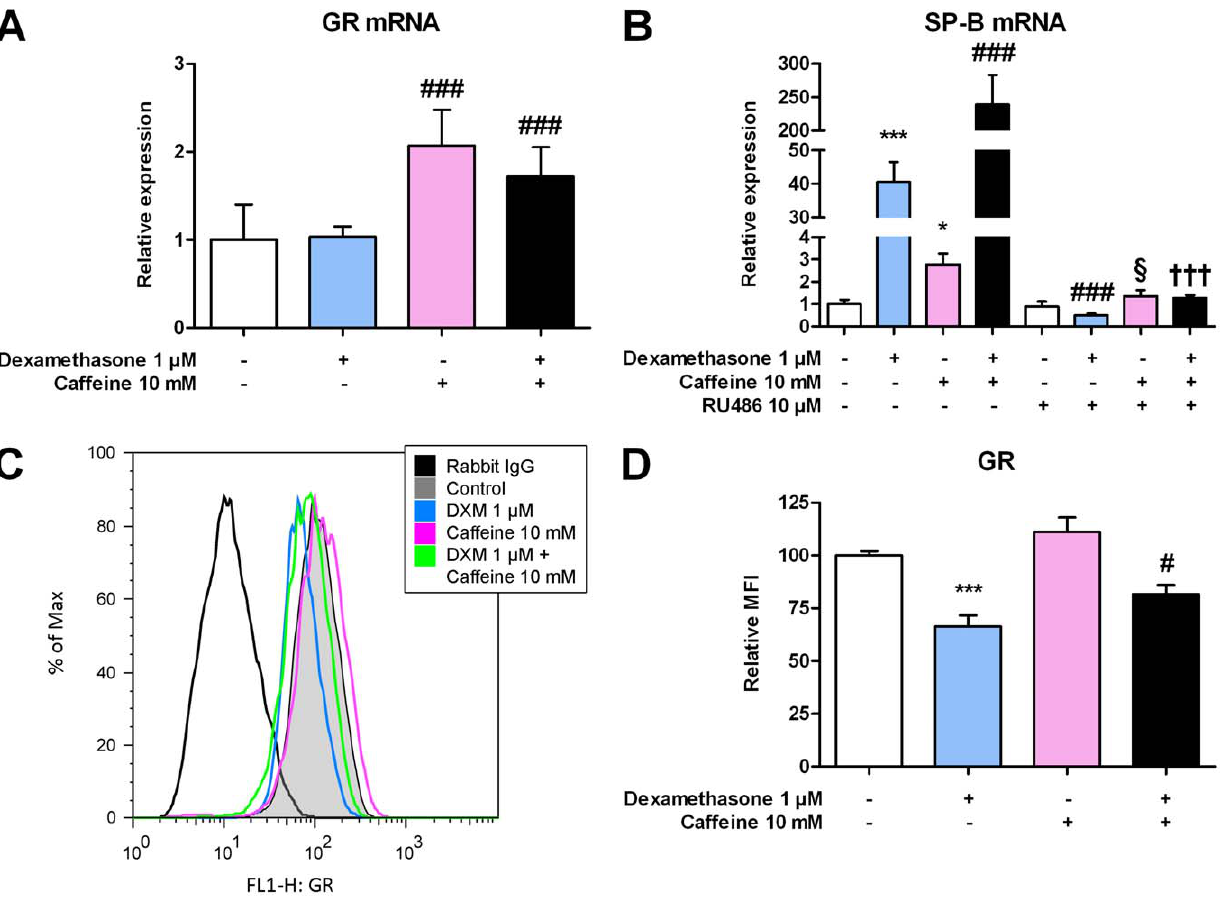
Figure 5. Involvement of the GR in expression of SP-B mRNA. ( A ) H441 cells were treated with dexamethasone, caffeine, or combinations, and 24 h later qPCR of GR mRNA was performed. Measured mRNA levels were normalized to GAPDH, and fold differences compared to untreated cells were calculated. ( B ) H441 cells were treated with dexamethasone, caffeine, the GR antagonist RU486 (mifepristone), or combinations, and 16 h later qPCR of SP-B mRNA was performed. Measured mRNA levels were normalized to b -actin, and fold differences compared to untreated cells were calculated. ( C , D ) H441 cells were treated with dexamethasone (DXM), caffeine, or combinations. After 48 h, cells were fixed, staining of the GR was performed, and cells were analyzed by flow cytometry. For A , B and D means 6 SD of n=3 independent experiments are shown. For C , a representative image of n=3 independent experiments is shown. * p , 0.05 and *** p , 0.001 compared to control cells, ### p , 0.001 compared to cells treated with dexamethasone, 1 p , 0.05 compared to cells treated with caffeine, {{{ p , 0.001 compared to cells treated with dexamethasone and caffeine. MFI, mean fluorescence intensity.